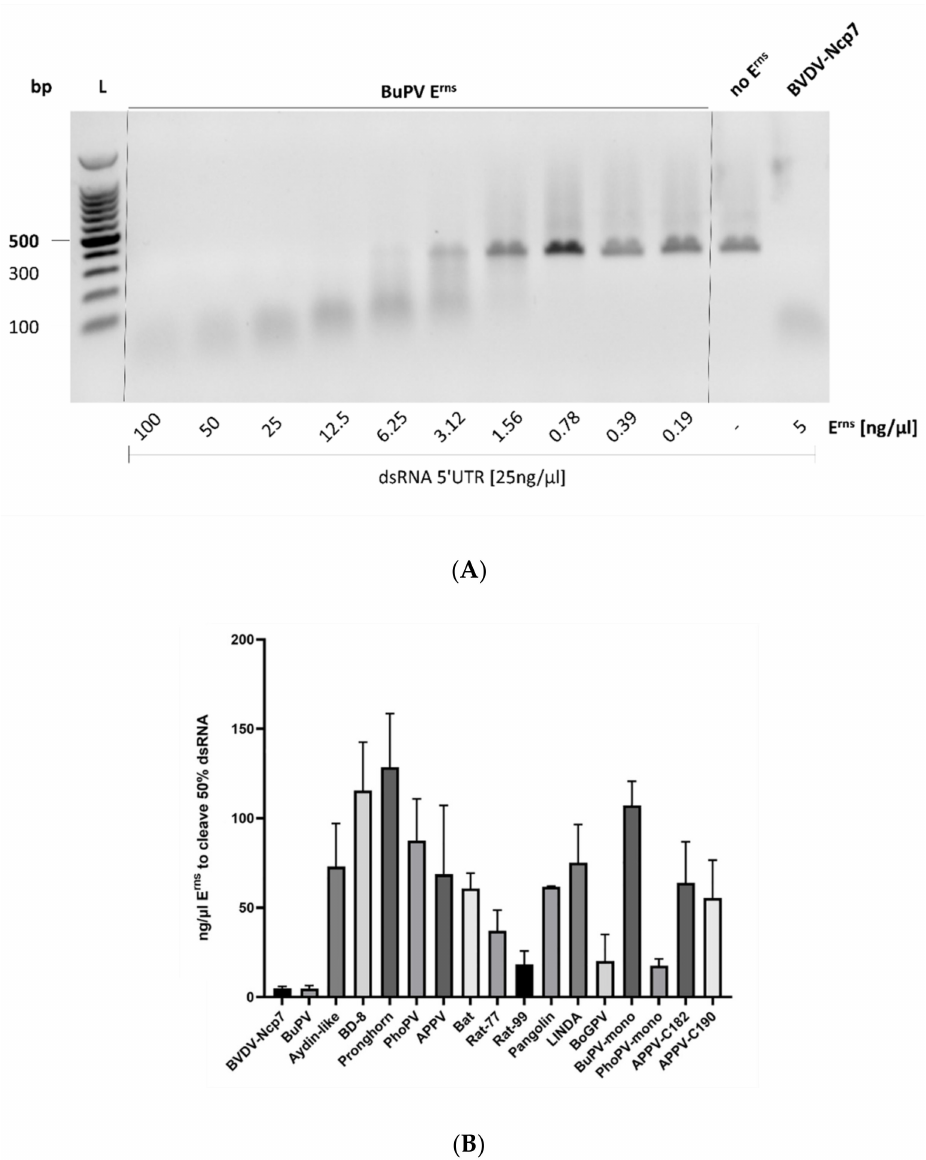
Figure 3. RNase activity of the E rns proteins of different pestivirus species analyzed. ( A ) Agarose gel of BuPV-E rns is shown as an example for the enzymatic assay, with decreasing signal for the 300 bp dsRNA with increasing concentrations of E rns . The sizes of the 100, 300, and 500 bp fragments within the 100 bp ladder (L) as size marker are indicated. The uncropped gel is available in Supplementary Material Figure S2. ( B ) Quantification of the gels as shown in panel A, estimating the amount of the various E rns proteins required to reduce the signal of dsRNA by 50% (n = 3 ± SD). Proteins that did not display any detectable activity (i.e., E rns of Gir-PG2, Gir-H138 and Gir- ∆ Ct), or for which the 50% value could not be calculated (i.e., the chimeric E rns proteins H138-Ncp7-1 and H138-Ncp7-2), are not shown. The activities relative to E rns of BVDV-Ncp7 are shown in Table